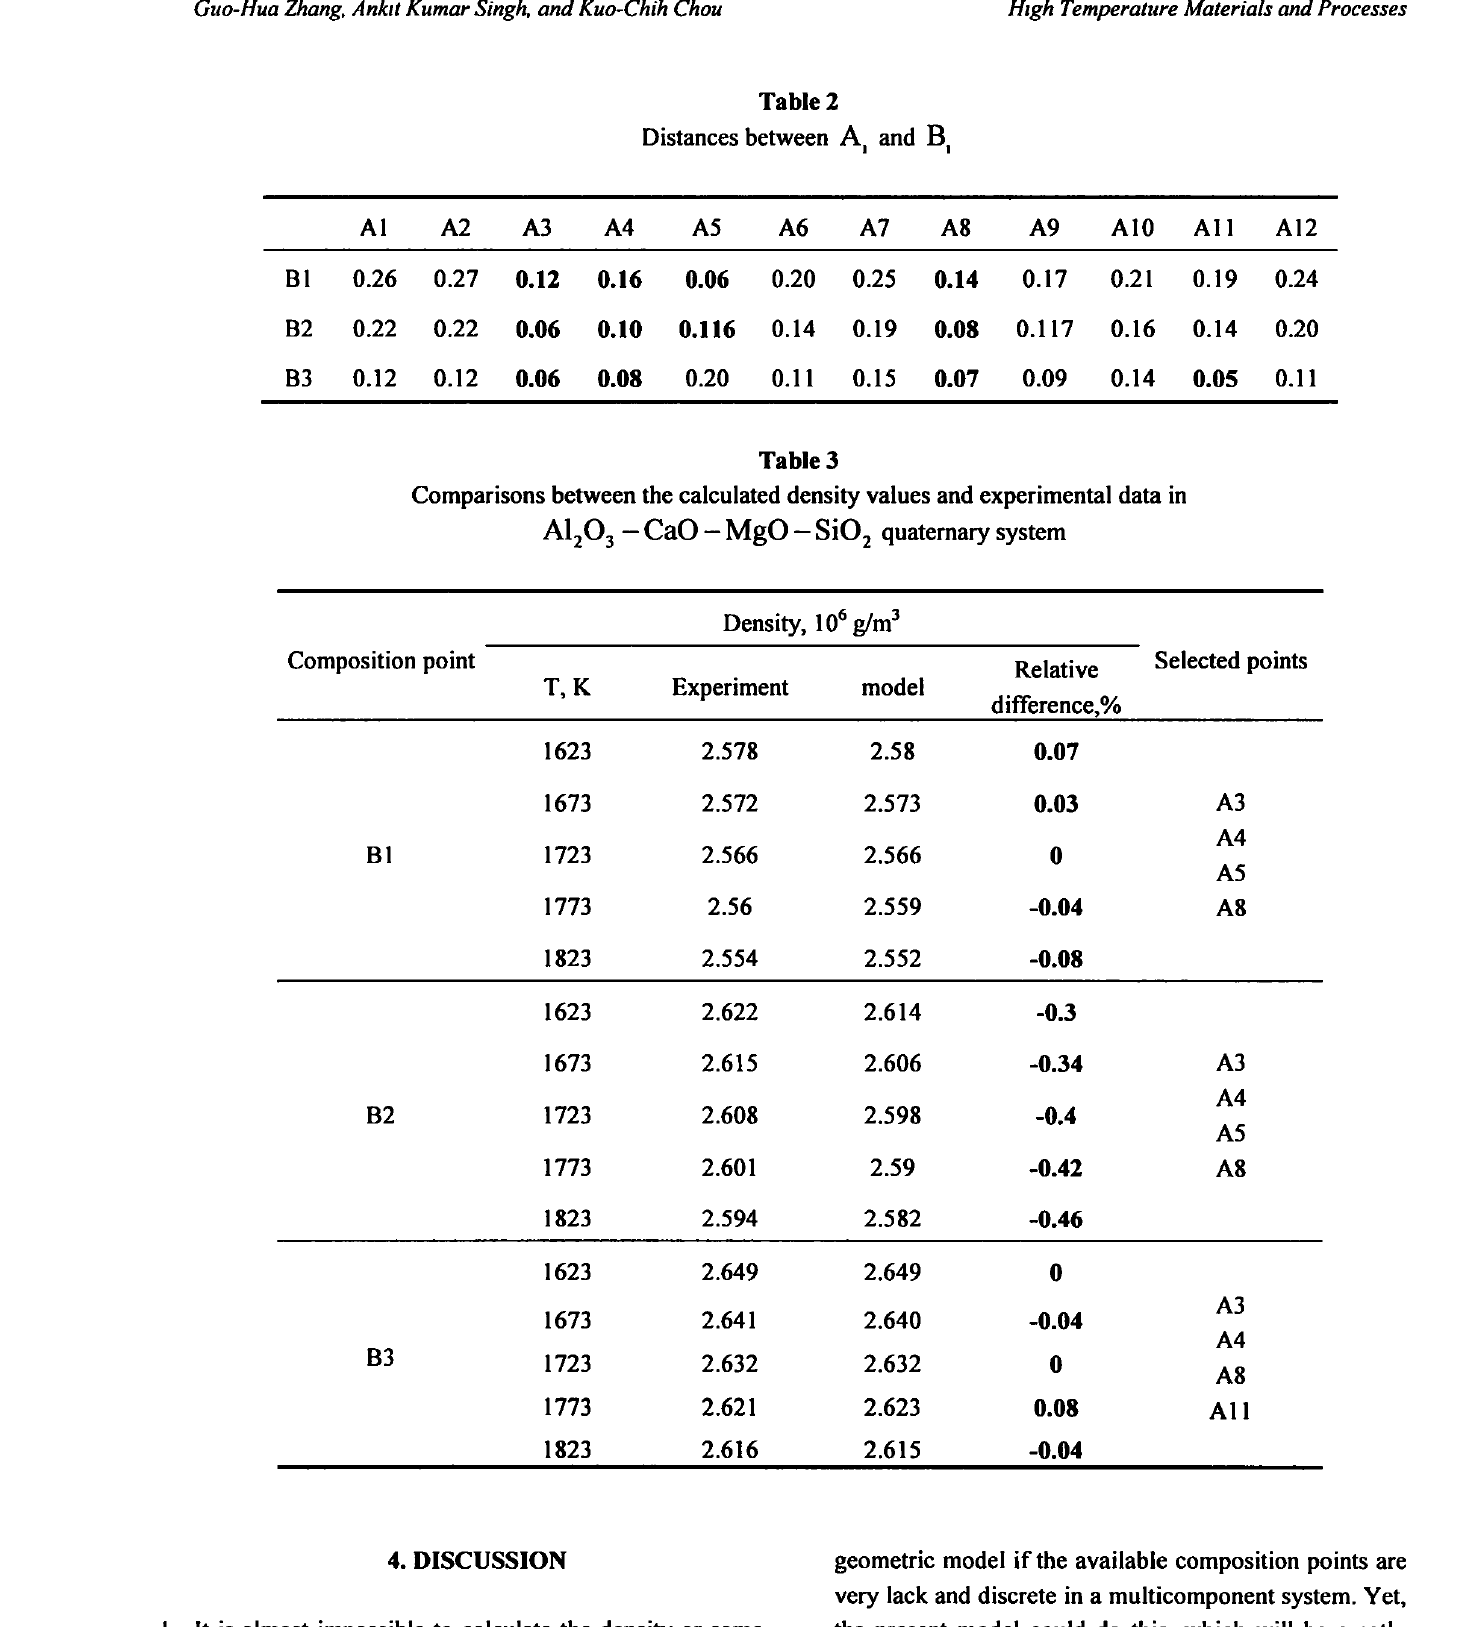
Distances between A. and B.